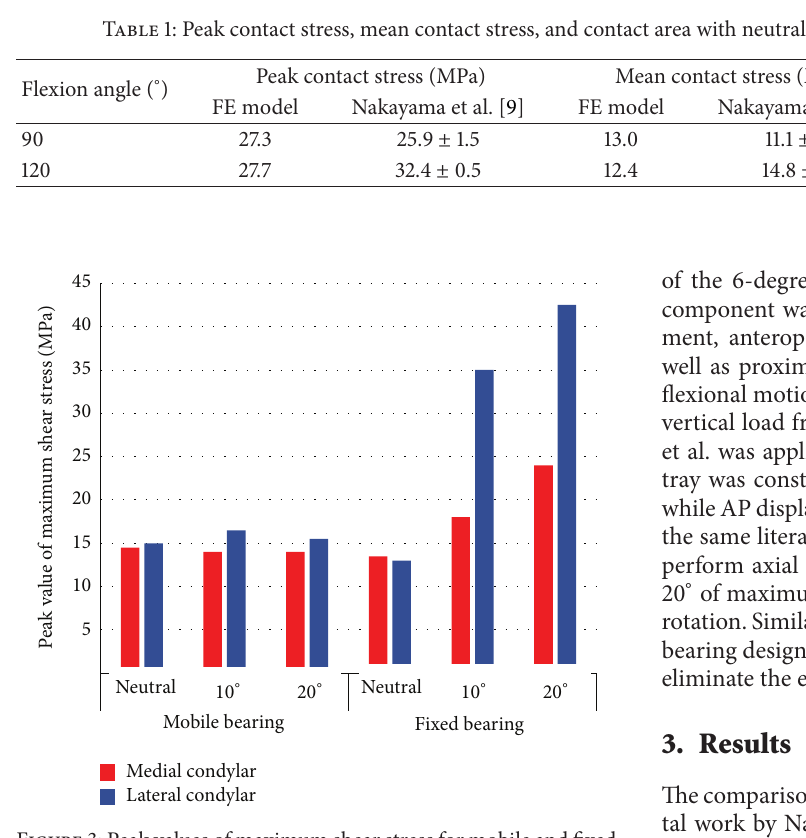
Figure 3: Peak values of maximum shear stress for mobile and fixed bearing TKA at neutral, 10 ∘ , and 20 ∘ internal tibial